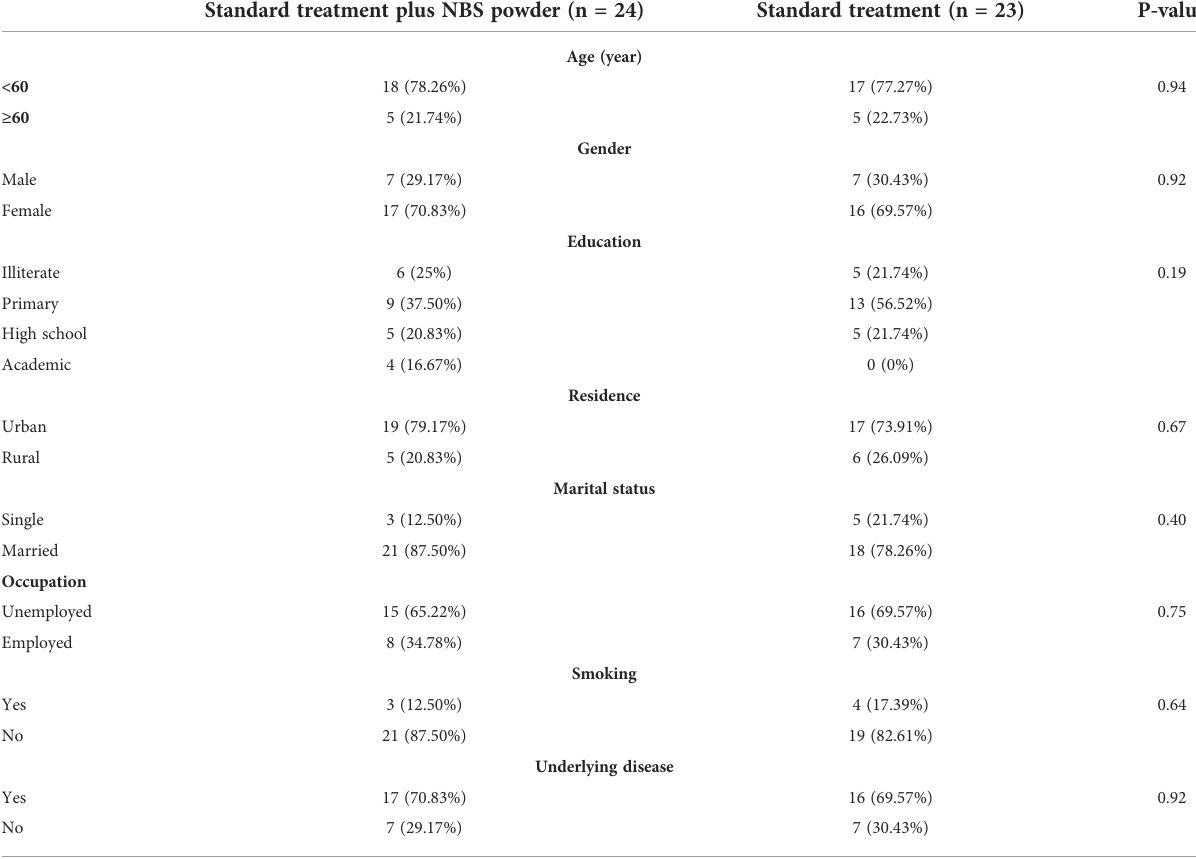
TABLE 1 Characteristics of patients in intervention and control